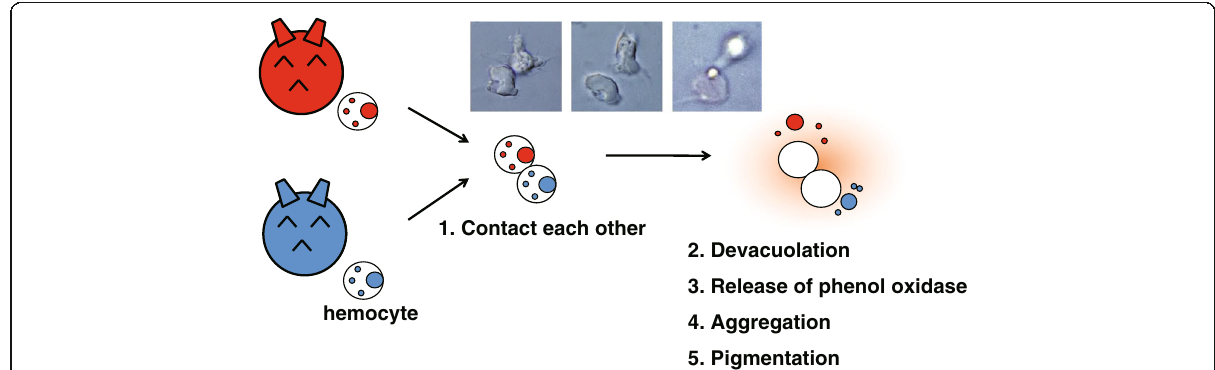
Fig. 1 Scheme of the contact reaction in Halocynthia roretzi. When hemocytes from two cross-reactive individuals are mixed in vitro, they immediately release their vacuole contents and phenol oxidase, agglutinate, and become pigmented as part of the contact reaction (CR)